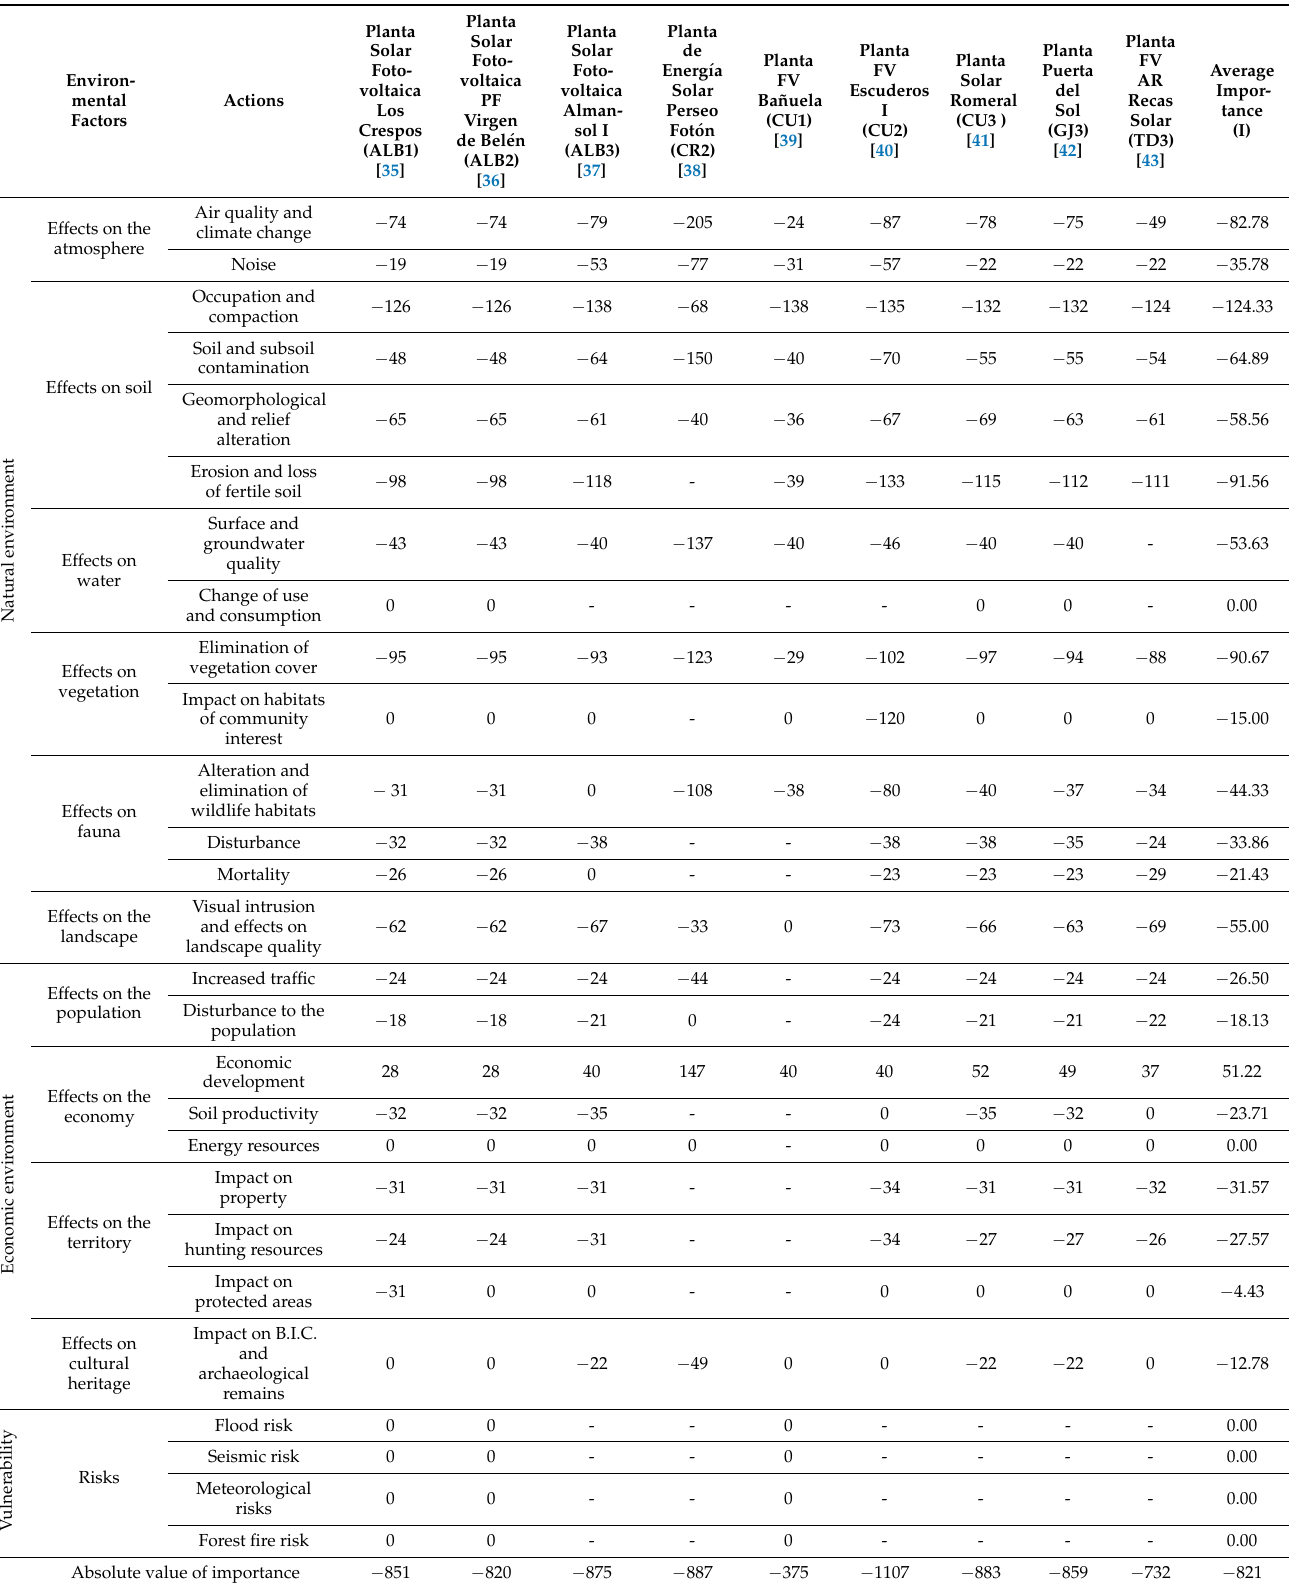
Table A4. Synthesis of the different importance matrix conducted in the selected PV plants (construc- tion